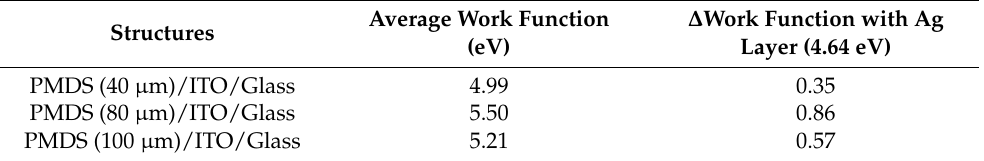
Table 2. Summarized work function of PDMS layers of various thickness, (a) 40, (b) 80, (c) 100 µ m, on ITO substrate and difference in work function with Ag electrode.